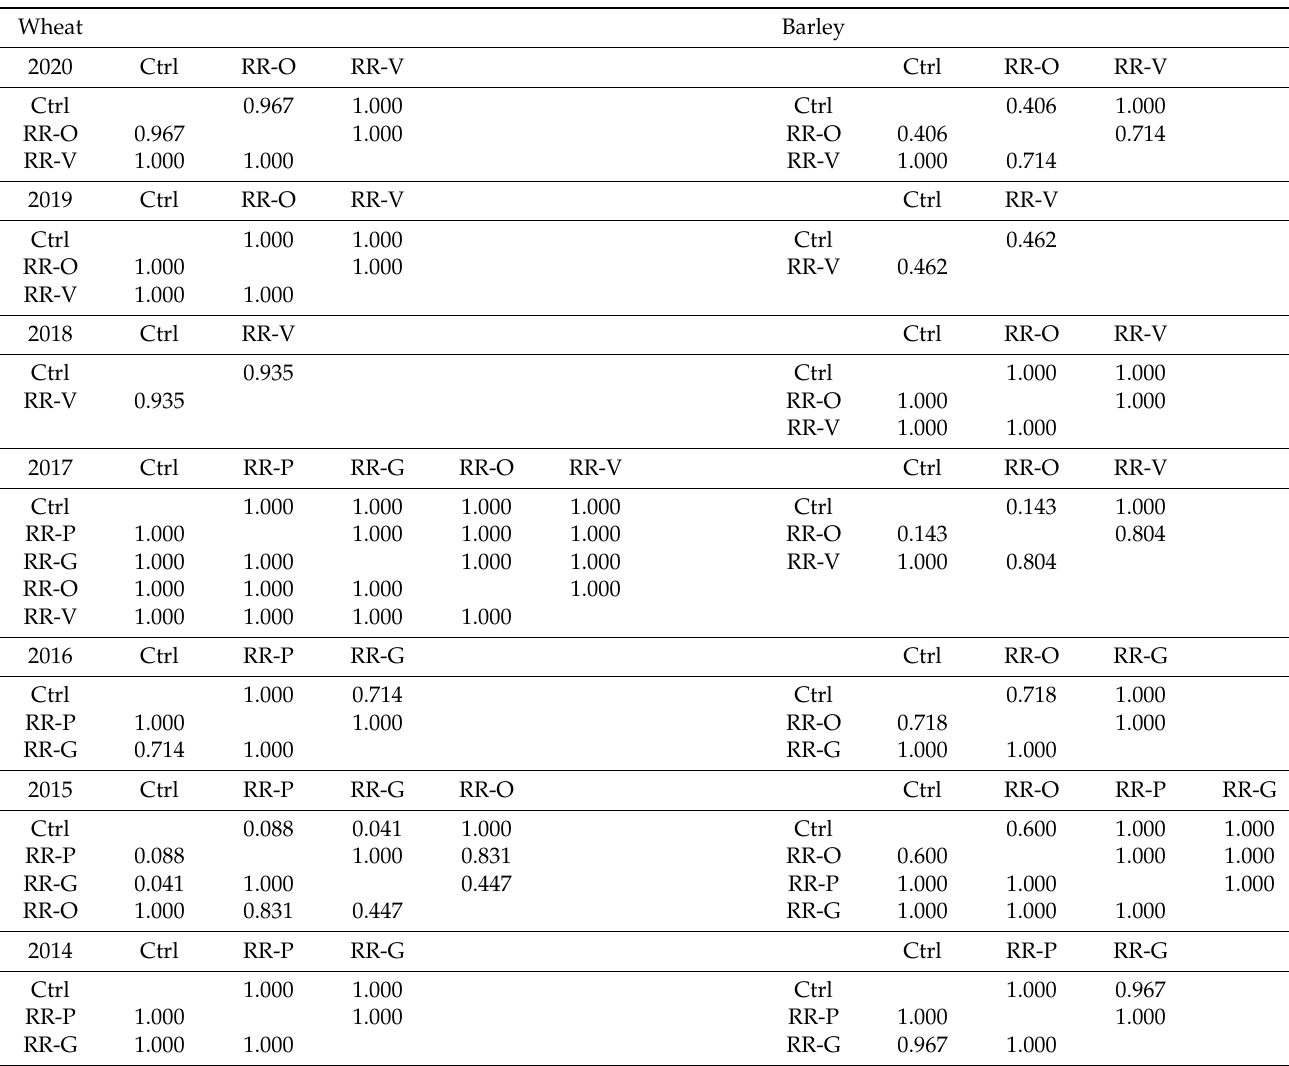
Table 2. The Kruskal–Wallis ANOVA non-parametric test with multiple comparisons of p -values performed on harvest yields of wheat and barley for individual